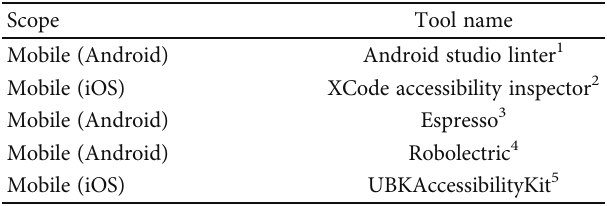
Table 3: Accessibility validation tools for